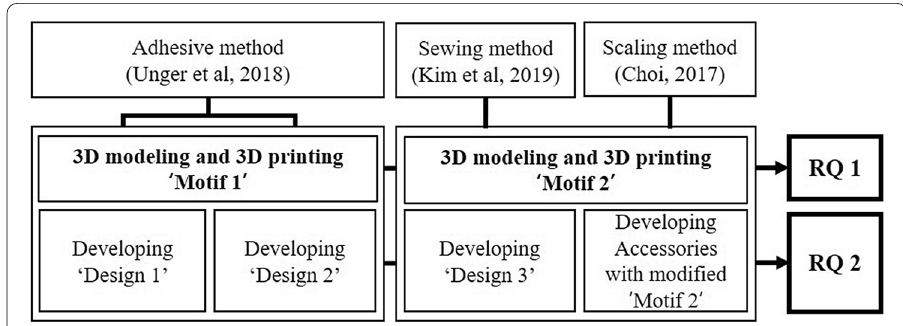
Fig. 1 Overview of the research phases and research